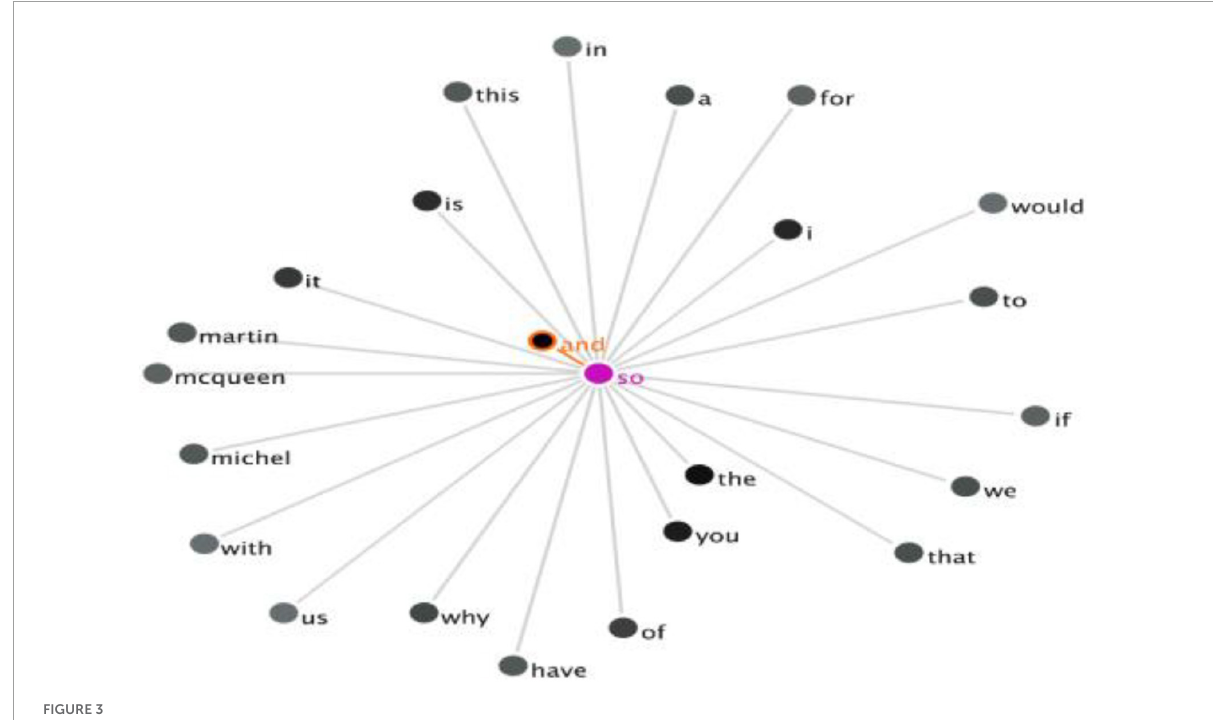
FIGURE3 The GraphColl of the co-occurrence of “and so” in the US Corpus.